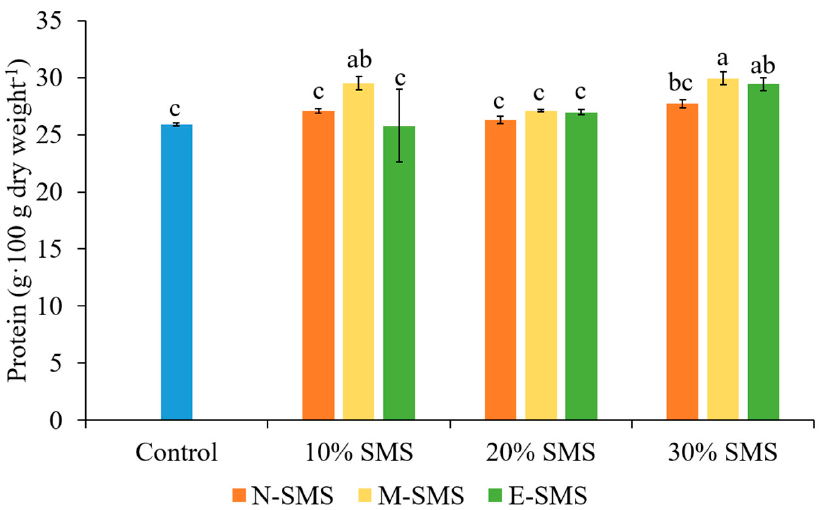
Figure 3. The protein content of P. ostreatus fruiting bodies in different substrates (mean ± SD, n = 3). Different letters above the bars indicate significant differences at p < 0.05.